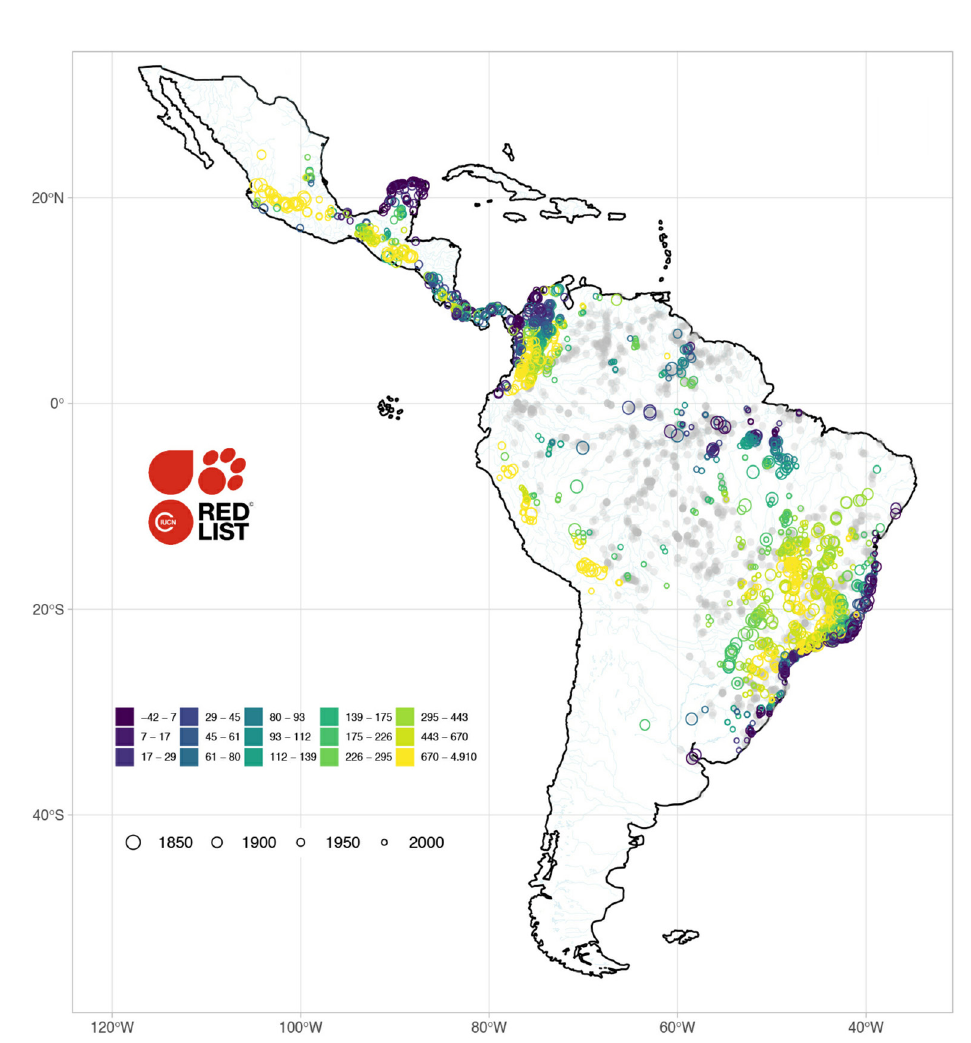
FIGURE 5 | Collection points for 442 threatened Neotropical freshwater fishes (NFF) colored by elevation and sized by species' description year. Threatened NFF species are often those described decades ago, with range-restricted distributions in the upland rivers of the Brazilian Shield and the Colombian Andes, and coastal Atlantic and Caribbean drainages. CR: Critically Endangered; EN: Endangered; VU: Vulnerable; DD: Data Deficient (gray). Data for 4,412 localities with geographic